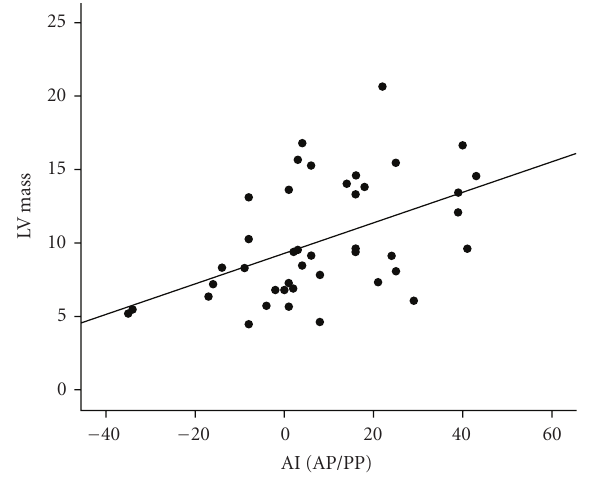
Figure 2: Relation between AI and LV mass.